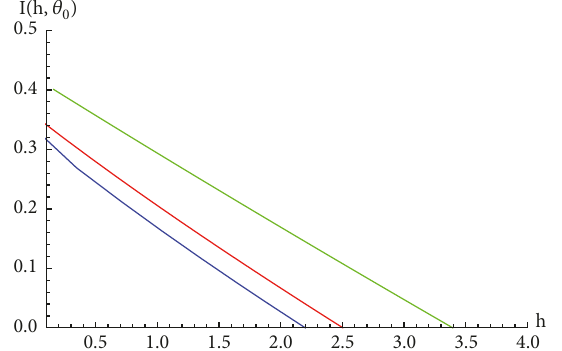
Figure 9: Relation between 𝐼(ℎ, 𝜃 0 ) and ℎ for the case 𝑟 = 0.2,𝑟 𝑚𝑖𝑛 = 50 . The green line, red line, and blue line correspond to 𝑄 = 0.5, 0.52, 0.54 ,